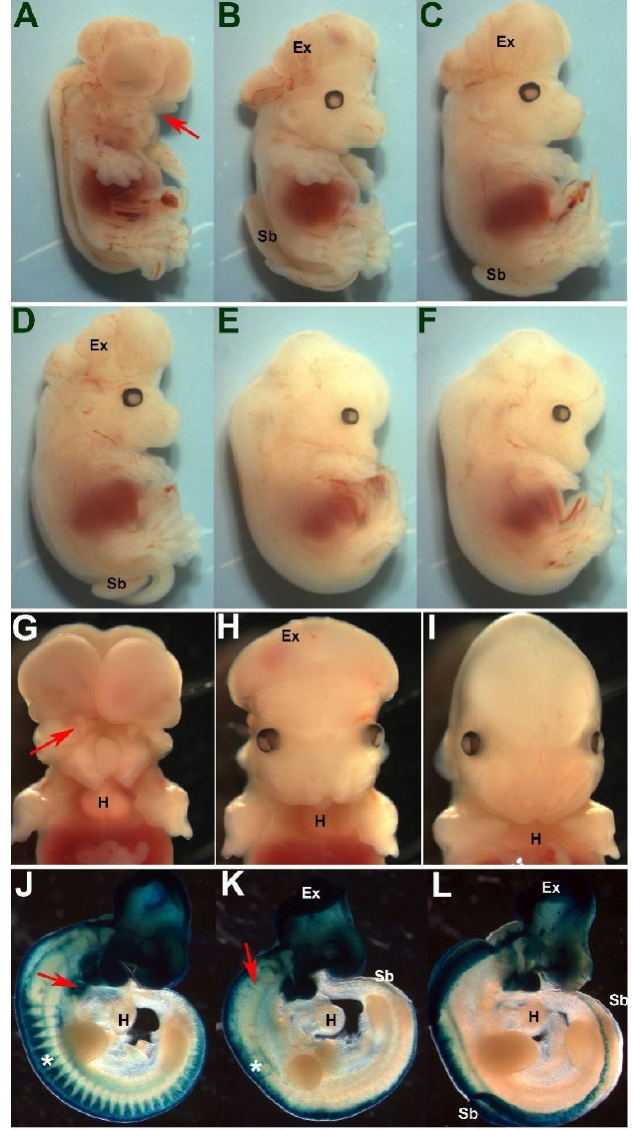
Figure 6. Pax3/7 double nulls exhibit exacerbated defects. ( A – F ) Whole E14.5 fetal lateral (left) views of different combinations of Pax3 and Pax7 allelic status. Pax3 ∆ 5/ Δ 5 / Pax7 Δ 5/ Δ 5 double nulls exhibit craniorachischisis, contiguous with craniofacial dysplasia ( A , red arrow), but Pax3 ∆ 5/ Δ 5 / Pax7 Δ 5/+ ( B ), Pax3 ∆ 5/ Δ 5 / Pax7 +/+ ( C ) and Pax3 ∆ 5/+ / Pax7 Δ 5/+ ( D ) mutants only exhibit exencephaly (Ex) and spina bifida (Sb). ( G – I ) Frontal views demonstrate that Pax3 ∆ 5/ Δ 5 / Pax7 Δ 5/ Δ 5 double nulls exhibit frontal clefting ( G , arrow) but neither Pax3 ∆ 5/ Δ 5 / Pax7 +/+ ( H ) and Pax3 +/+ / Pax7 Δ 5/ Δ 5 ( I ) null facial morphogenesis remained unperturbed. ( J – L ) Wnt1 Cre /R26r LacZ lineage mapping of E11 neural crest cells revealed robust stain- ing (blue) in Pax3 +/+ / Pax7 Δ 5/ Δ 5 neural crest-derived DRGs ( J , *), emigrating neural crest and cardiac neural crest in the circumpharyngeal crest adjacent to the outflow tract ( J , K , red arrows), as well as the craniofacial and neural tube cells. Note this pattern is identical; to that in wildtype embryos [15]. However, lacZ staining of Pax3 ∆ 5/ Δ 5 / Pax7 Δ 5/+ DRGs and emigrating cardiac neural crest is severely diminished ( K ), and lacZ staining of Pax3 ∆ 5/ Δ 5 /Pax7 +/+ DRGs and emigrating cardiac neural crest is totally absent ( K ). Further, spina bifida neural tube closure defect is more extensive in Pax3 ∆ 5/ Δ 5 / Pax7 Δ 5/ Δ 5 double nulls.